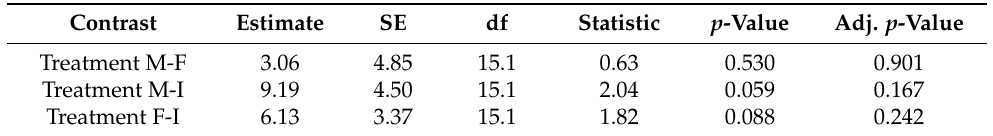
Site O19E was excluded from the